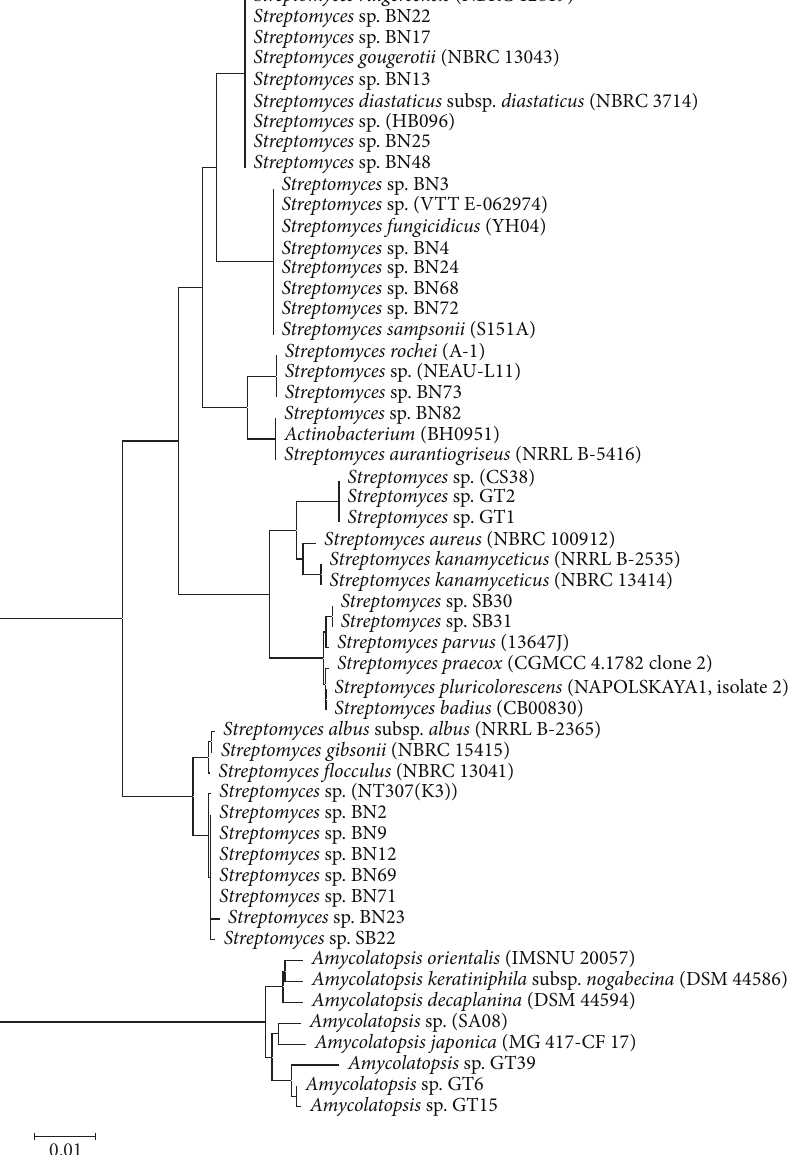
Figure 5: Evolutionary relationships of taxa: the evolutionary history was inferred using the neighbor-joining method [71]. The optimal tree with the sum of branch length = 0.21501137 is shown. The tree is drawn to scale, with branch lengths in the same units as those of the evolutionary distances used to infer the phylogenetic tree. The evolutionary distances were computed using the maximum composite likelihood method [72] and are in the units of the number of base substitutions per site. The analysis involved 55 nucleotide sequences. Codon positions included were 1st + 2nd + 3rd + noncoding. All positions containing gaps and missing data were eliminated. There were a total of 1392 positions in the final dataset. Evolutionary analyses were conducted in MEGA5 [32]. The scale bar represents 0.01 substitutions per nucleotide